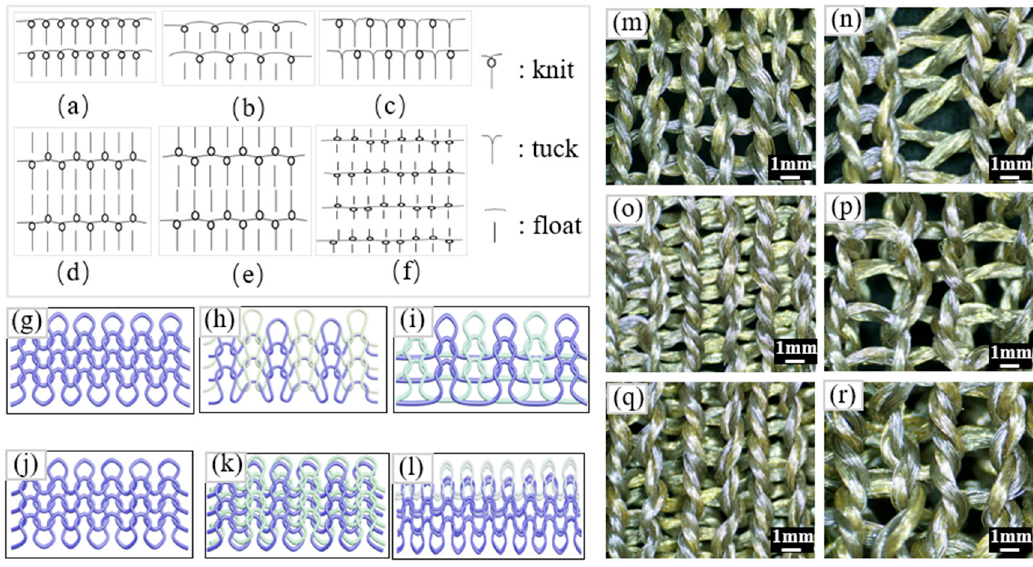
Table 2. Knitting parameters of knitted samples.